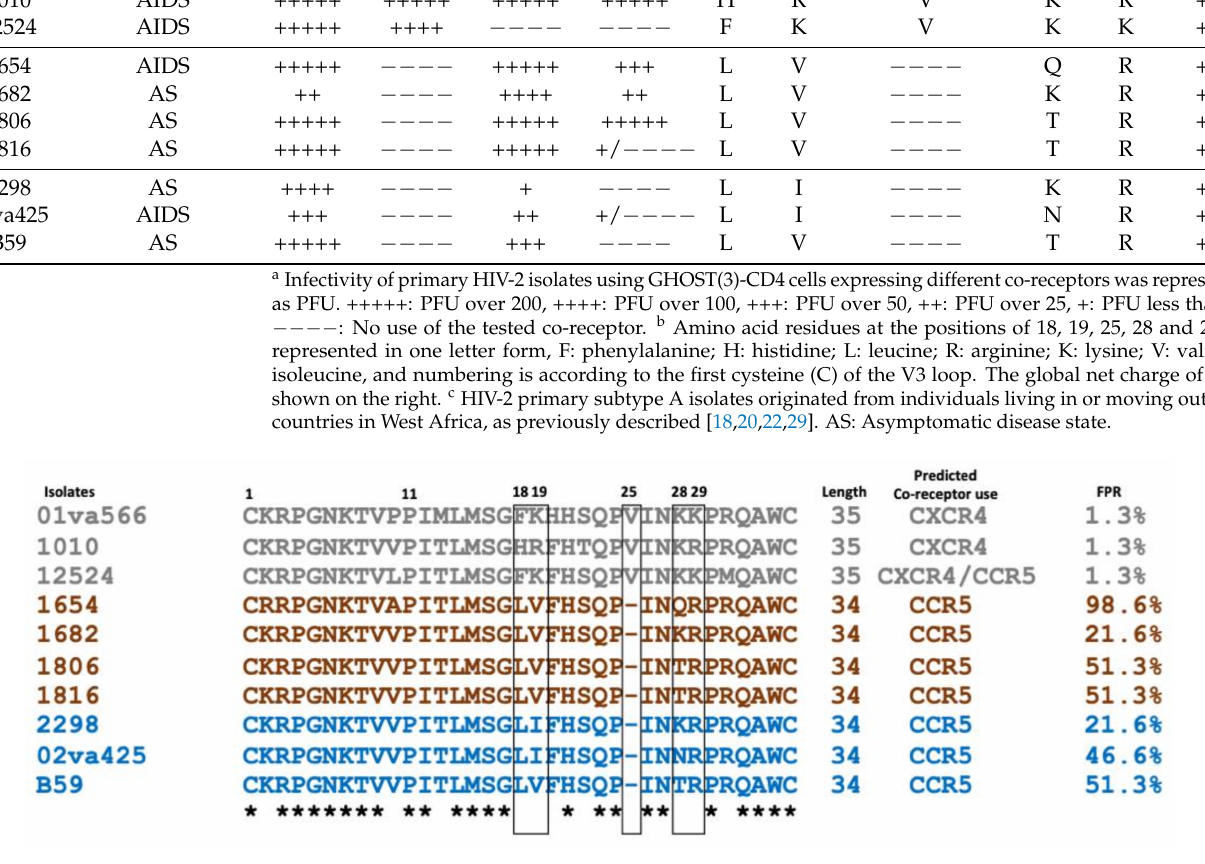
Figure 1. V3 loop amino acid sequence alignment and prediction of CXCR4-use by geno2pheno[coreceptor-hiv2] online server. Amino acid numbered according to the first cysteine (C) residue of the HIV-2 Env V3 loop region. The black boxes highlight the positions 18, 19, 25, 28 and 29 of the V3 loop, (*) indicate highly conserved residues and (-) represents a gap. The FPR (false positive rate) represents the probability of incorrect classifying a non-CXCR4-using (R5 virus) as a CXCR4-user, where the FPR cut off is 5%